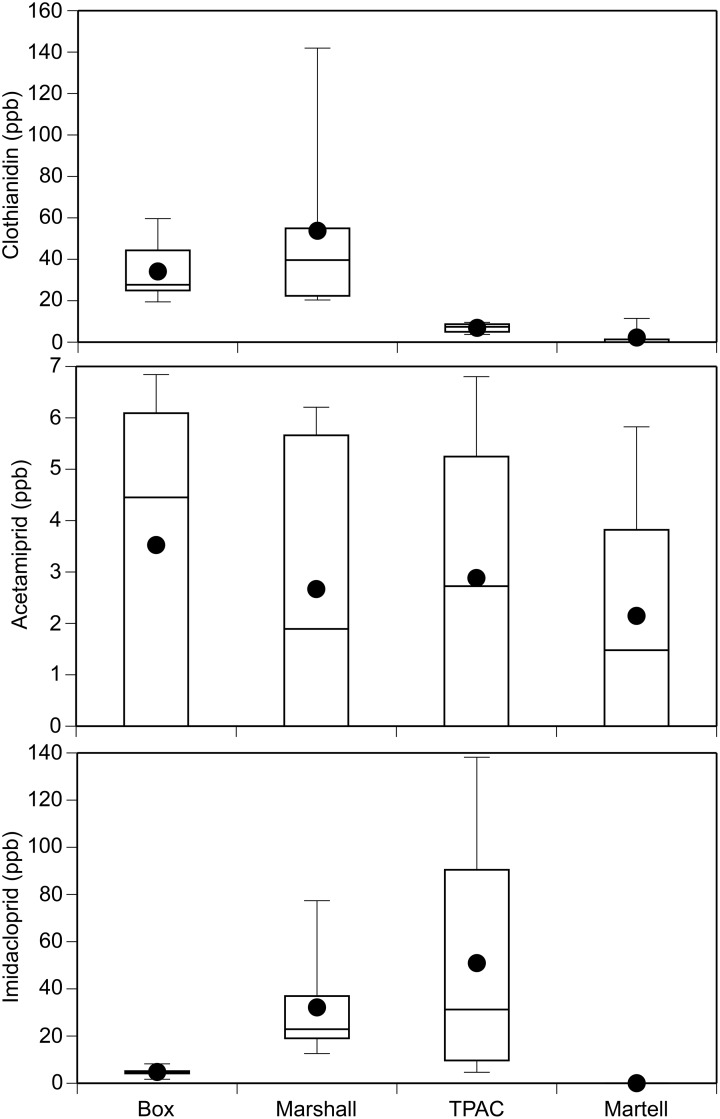
Boxplots of clothianidin, imidacloprid, and acetamiprid concentrations (ppb) detected in soil samples at four sites in Tippecanoe County, Indiana.Data includes samples taken throughout the growing season.